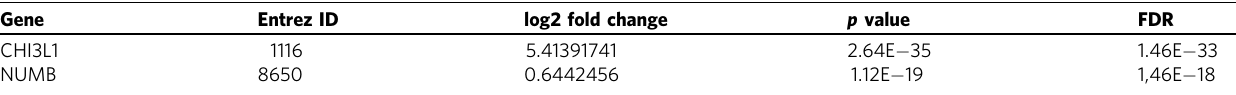
Comparison of RNA expression data (TCGA) of molecular glioblastoma ( n = 56) and molecular 1p/19q-codeleted oligodendroglioma ( n = 70) reveals downregulation of genes associated with NOTCH1 pathway activation in glioblastoma and upregulation of genes associated with NOTCH1 pathway inhibition. FDR False discovery